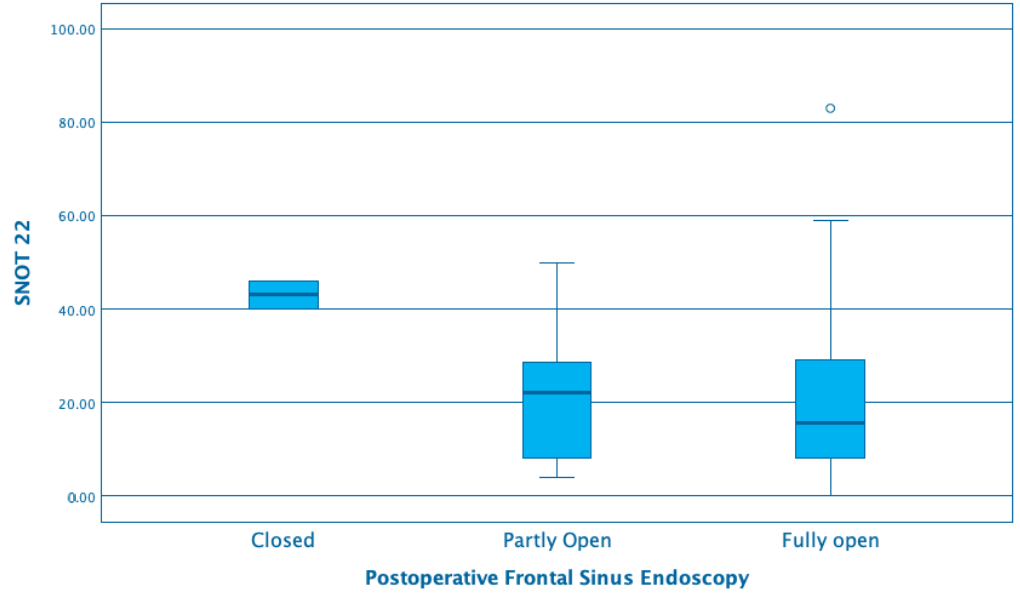
Figure 2. SNOT 22 mean and range by postoperative frontal sinus endoscopy.